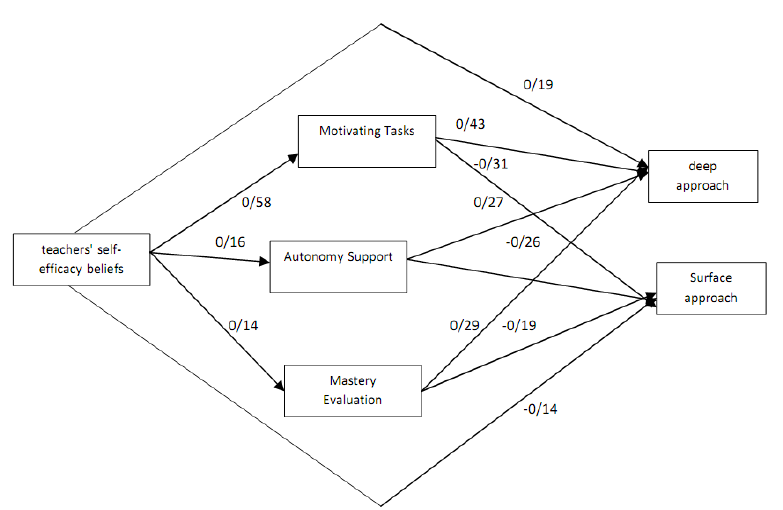
Figure 2 : fitted model for relationship between teacher efficacy, students' perception of classroom structure and and their learning